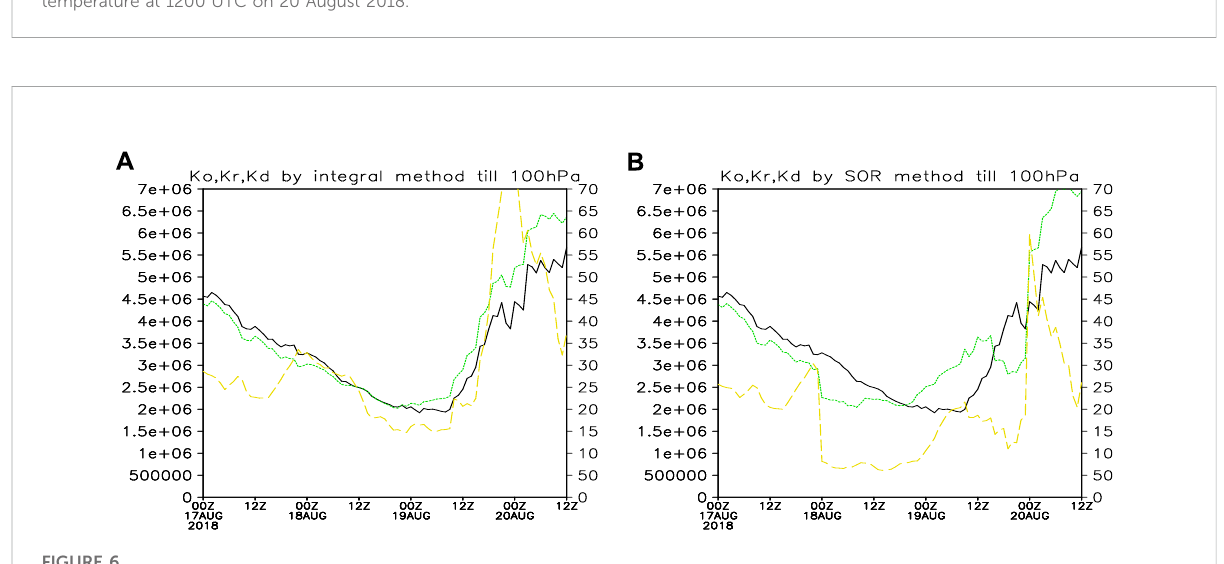
FIGURE 6 K0 (black), Kr (green), and Kd (yellow) by (A) the hybrid method, and (B) the SOR method.